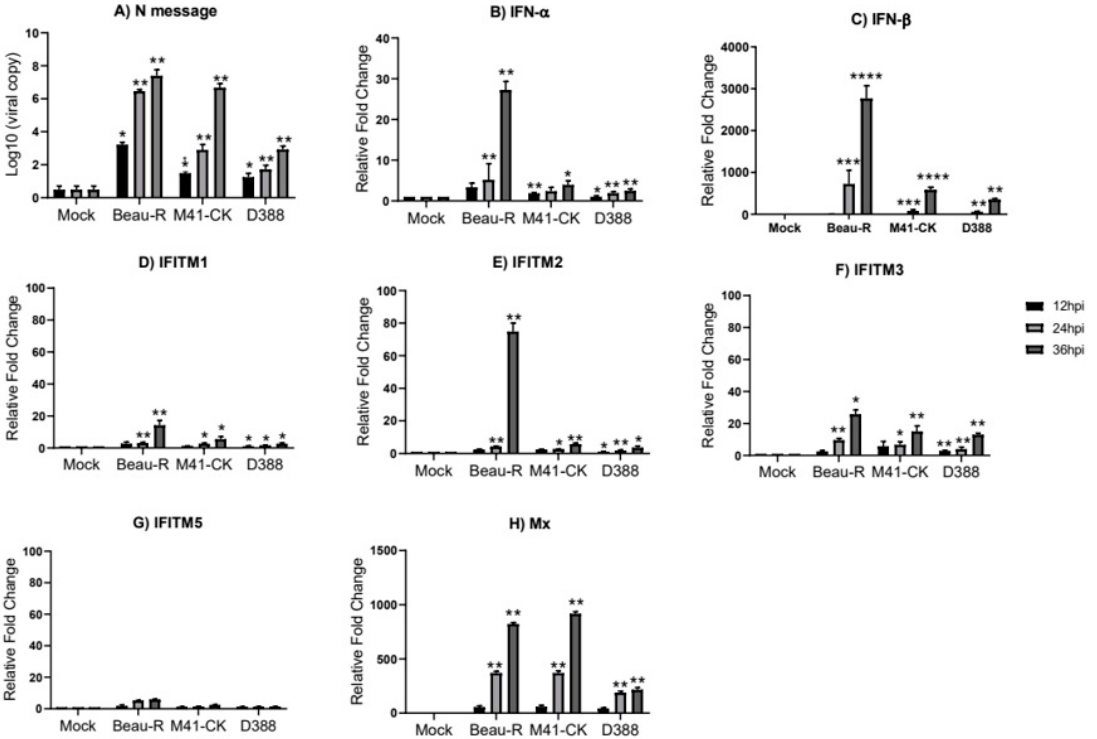
Figure 4. Infection of chick kidney (CK) cells with Beau-R, M41-CK and D388 upregulates the expression of the chIFITMs and IFNs . ( A ) Replicating virus detected by qRT-PCR using primers and a probe specific for IBV N message. The expression level and log fold change of ( B ) IFN- α , ( C ) IFN- β , ( D – G ) chIFITM1 , 2 , 3 and 5 and ( H ) Mx were measured using qRT-PCR after infection with Beau-R, M41-CK or D388 (MOI 1) in CK cells normalized to RPL13 and RPLPO housekeeping genes. Error bars show standard deviations of the means ( n = 3), * indicates p < 0.05, ** indicates p < 0.01, *** indicates p < 0.001, **** indicates p < 0.0001. ANOVA data were corrected for multiple comparisons using the Bonferroni adjustment method (GraphPad).